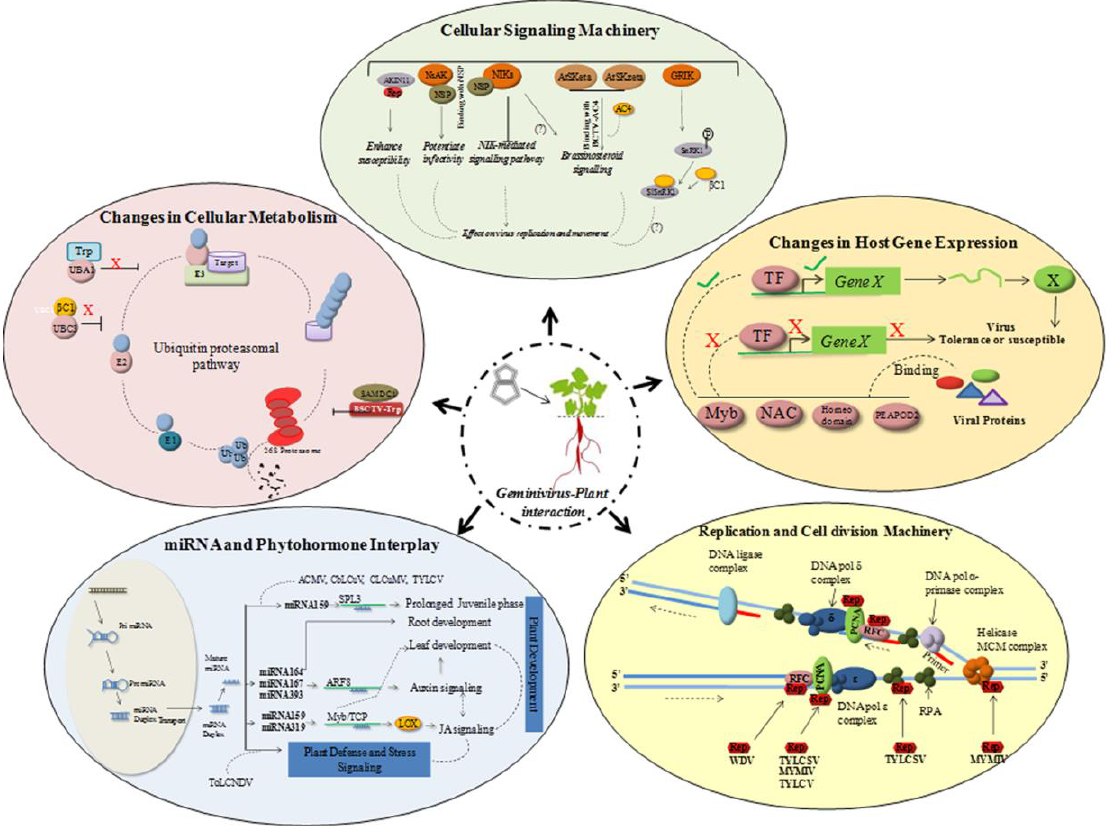
Figure 2. Geminivirus – plant host interactions. Geminivirus entry into plant host induces changes in gene expression patterns, cellular signaling process, replication, cell division, protein degradation and miRNA-phytohormone interplay .